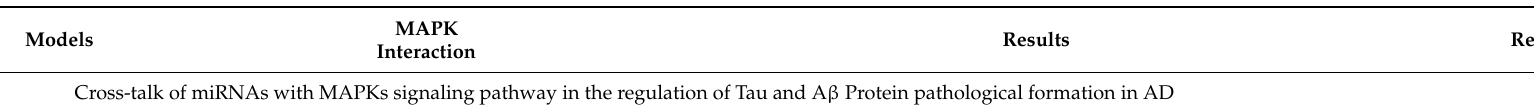
Table 1. Summary of included AD experimental models that highlight the role of miRNAs and MAPKs in the pathological mechanisms of